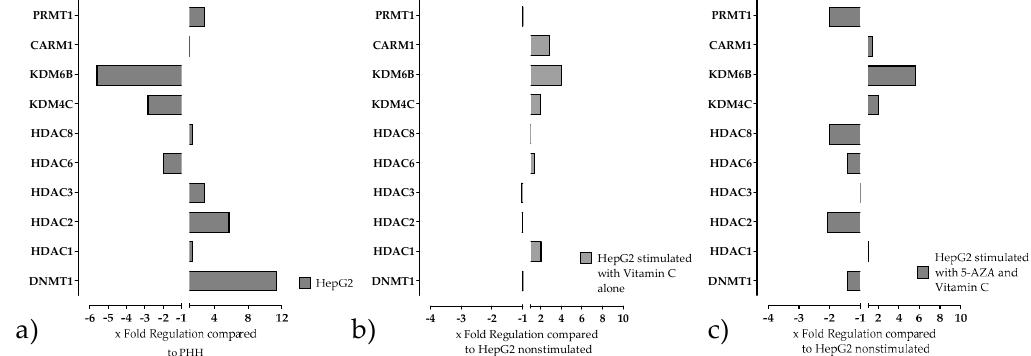
Figure 2. Expression of chromatin modifying genes in HepG2 cells before and after stimulation with Vitamin C alone or in combination with 5-Azacytidine (5-AZA) was measured by using the Chromatin Modification Array. Genes responsible for the maintenance of metabolic properties of primary human hepatocytes (PHH) are selected. ( a ) Expression of chromatin modification genes in HepG2 compared to PHH ( b ) Changes in the expression of chromatin modification genes in HepG2 caused by treatment with Vitamin C compared to non- stimulated HepG2 cells. ( c ) Changes in the expression of chromatin modification genes in HepG2 caused by 5-AZA in combination with Vitamin C compared to non- stimulated HepG2 cells.